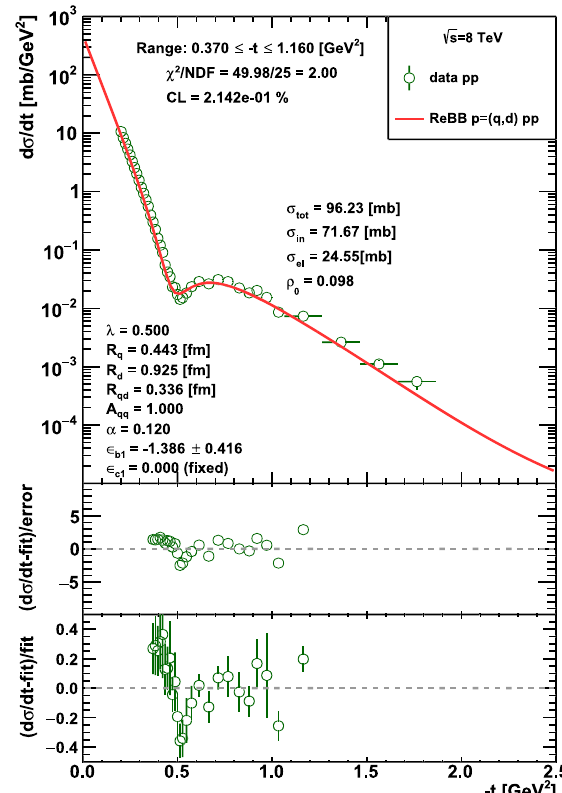
Fig. 1 Comparison of the pp differential cross section calculated from the ReBB model—using the energy calibration of the fit parameters done in Ref. [1]—with the 8 TeV pp differential cross section data measured and published by TOTEM in Ref. [15]. According to this publication [15], we consider half of the − t bin size of the data points as horizontal type A errors, when applying the χ 2 definition detailed in Ref. [1]. On this Figure, the shown values refer to pp elastic scat- tering, corresponding to the physical observables at t = 0, and the ReBB model parameter values obtained from those trends, that were determined previously in Ref.